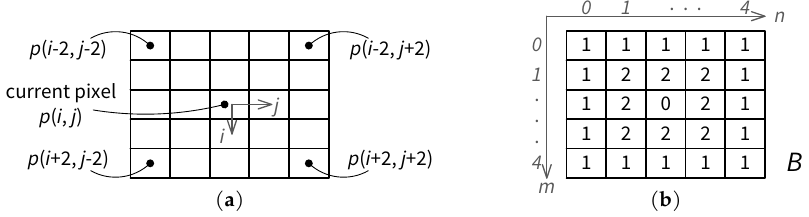
Figure 2. Pixel window for JND estimation and weighing factors for the background luminance: ( a ) JND estimation window of 5 × 5; and ( b ) weighing factor matrix B .